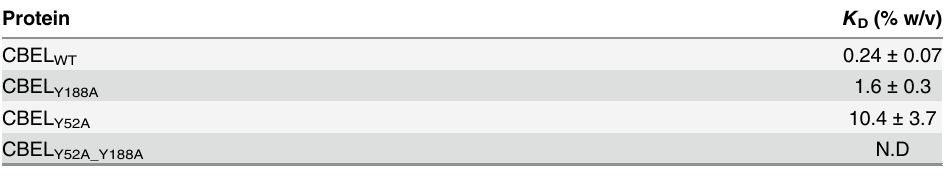
Table 2. Characterization of CBEL binding to cellulose nanocrystals by fluorescence